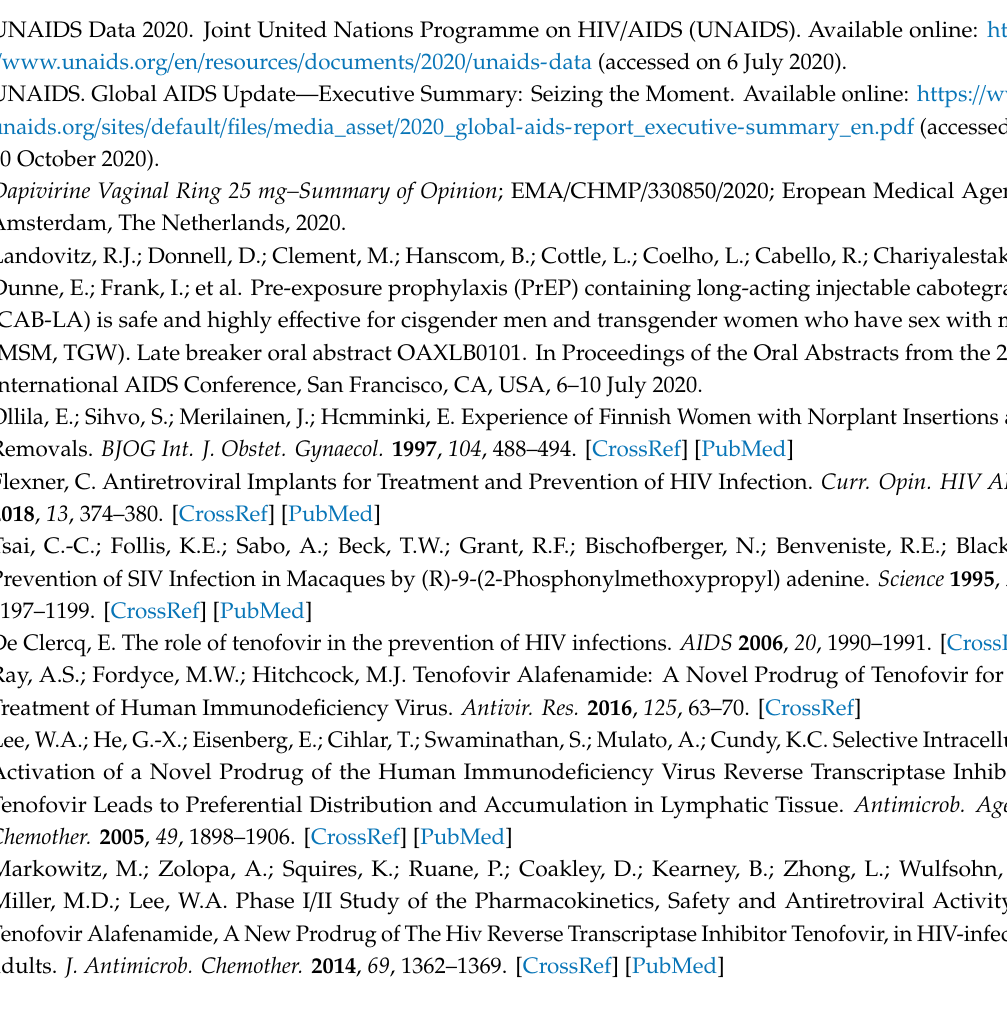
Figure S1: Daily release profiles of implants filled with TAF hemifumarate salt (TAFHF) (a) and TAF freebase (TAFFB) (b). Table S1: Chromatographic purity of TAFHF formulated with castor oil or PEG600 inside implants exposed to simulated physiological conditions over 120 days. Table S2: Chromatographic purity of TAFFB formulated with sesame oil or castor oil inside implants exposed to simulated physiological conditions over 210 days. Table S3: Water ingress within the implant reservoir of TAFHF formulated with castor oil or PEG600 measured via the loss-on-drying method. Table S4: Water ingress within the implant reservoir of TAFFB formulated with castor oil or sesame oil measured via loss-on-drying method. Table S5: Chromatographic purity profile of TAFHF castor oil and TAFFB sesame oil implants stored in open and closed foil pouches stored at 22 ◦ C / 50% RH and 40 ◦ C / 75% RH over